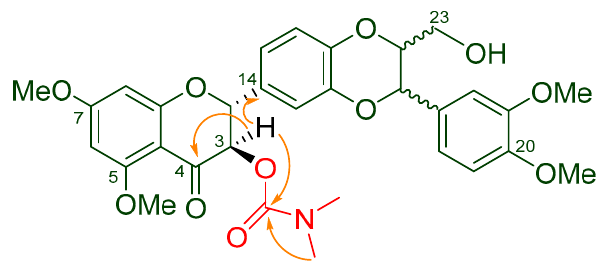
Table 2. NMR data for 5 ( 1 H NMR: 300 MHz; 13 C NMR: 75 MHz).